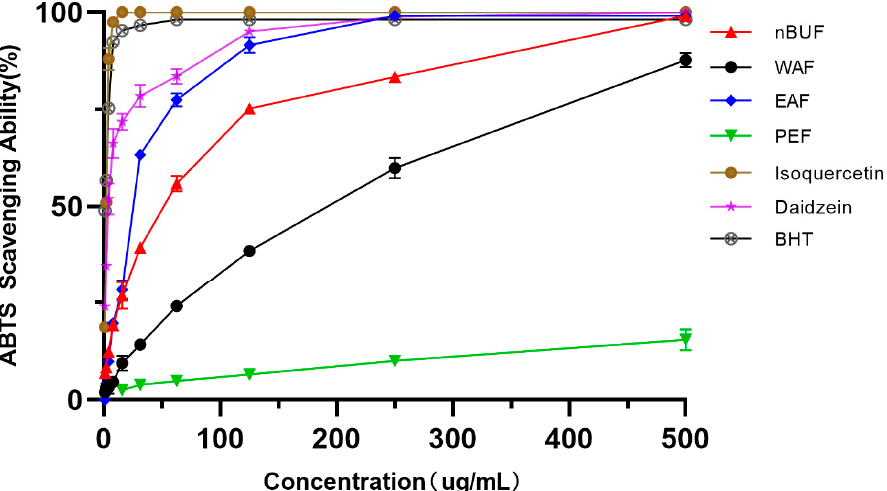
Figure 3. The ABTS scavenging abilities of different preliminary purification fractions and stan- dard samples.